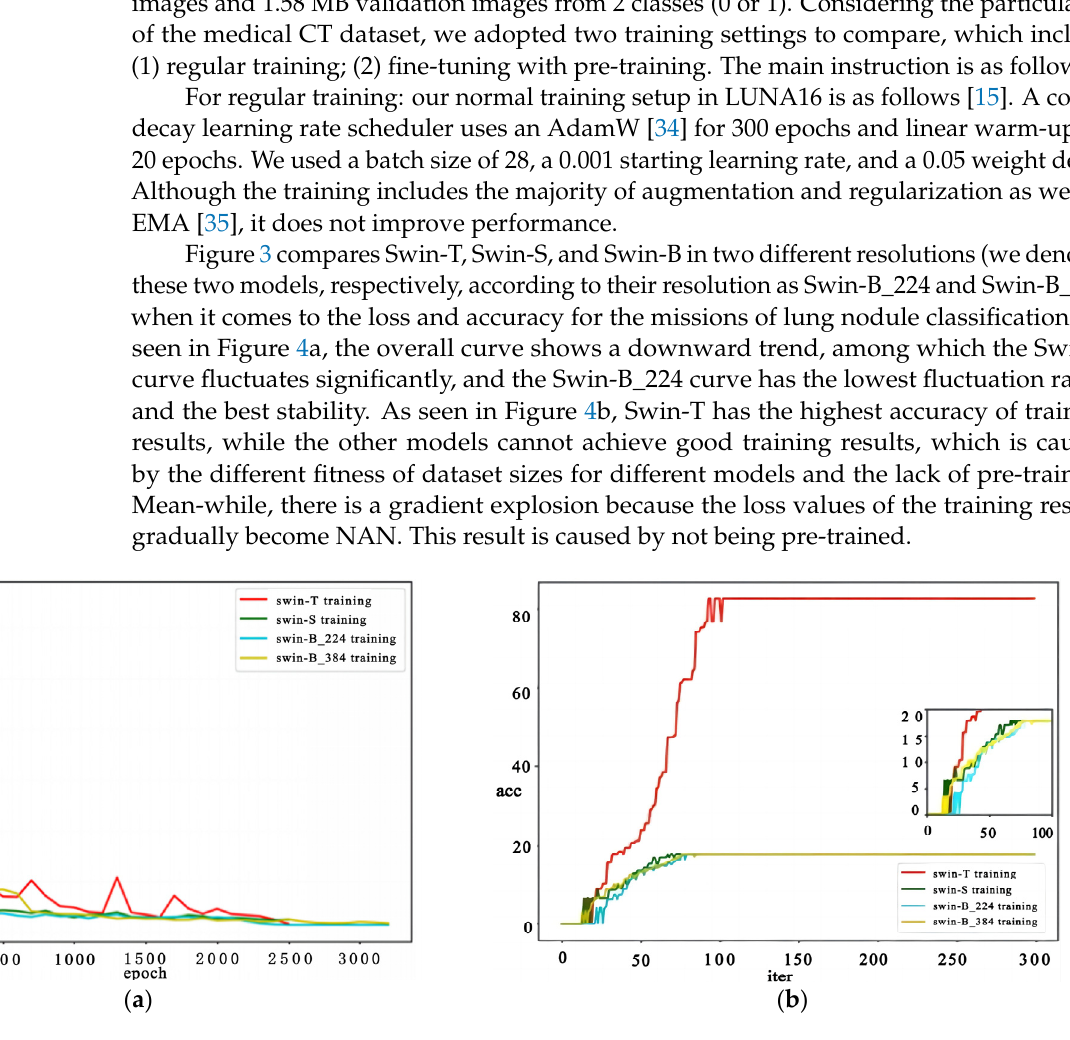
Table 2. Comparison of different backbones in regular training on LUNA16 classification. Method